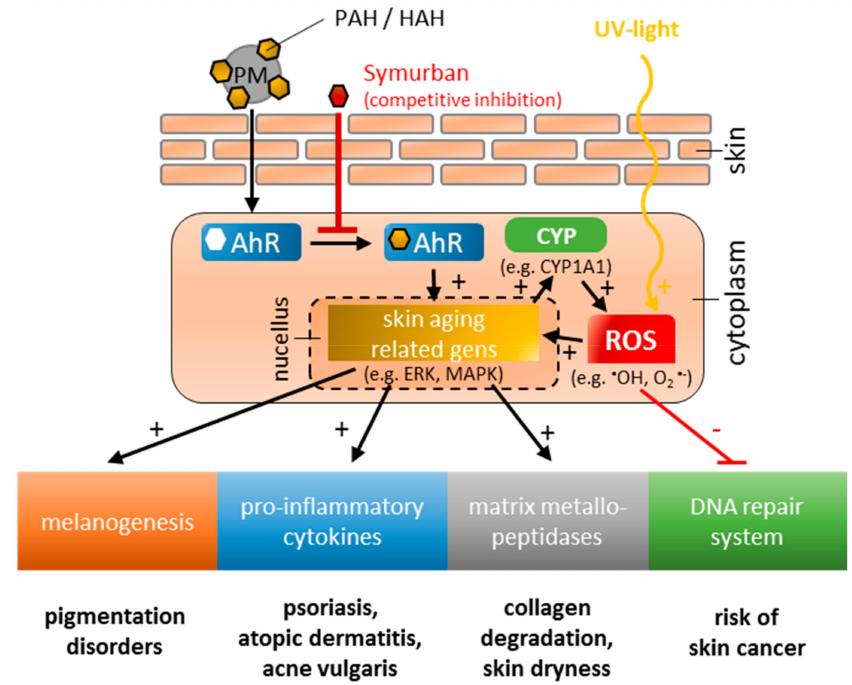
Figure 1. Schematic illustration of impacts on skin caused by polycyclic aromatic hydrocarbons (PAHs) and hydrogenated aromatic hydrocarbons (HAHs) adherent to the surface of particulate matter (PM), and UV-light